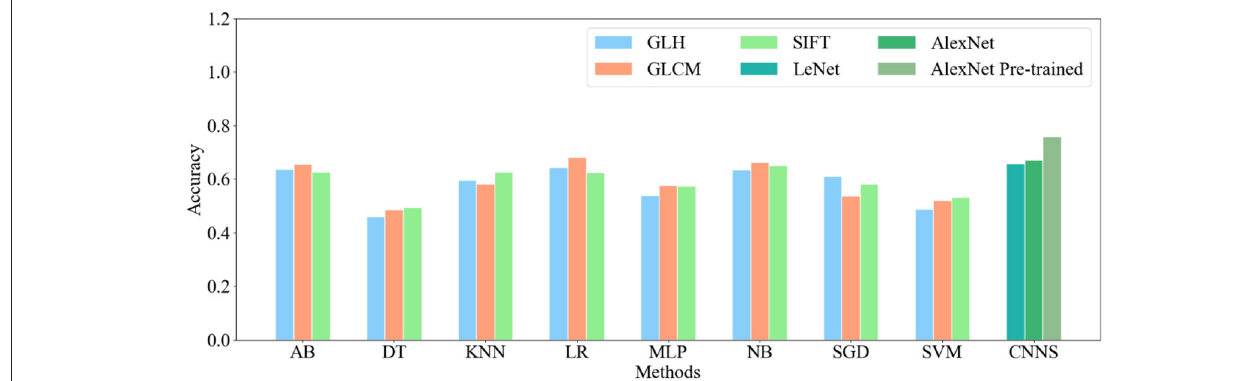
FIGURE 2 | Accuracy of all classification methods.